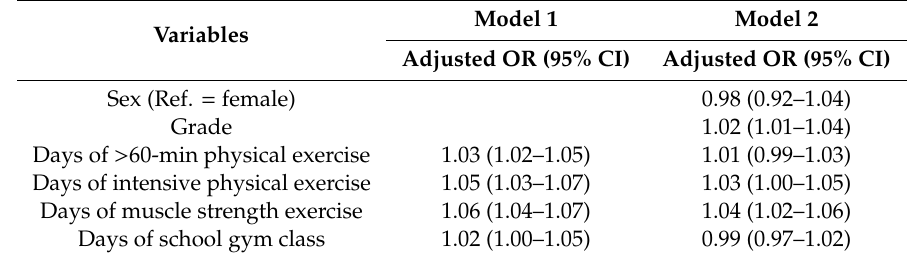
Table 6. The adjusted association of tooth fracture experience related to physical exercise by the complex-sample multivariable logistic regression